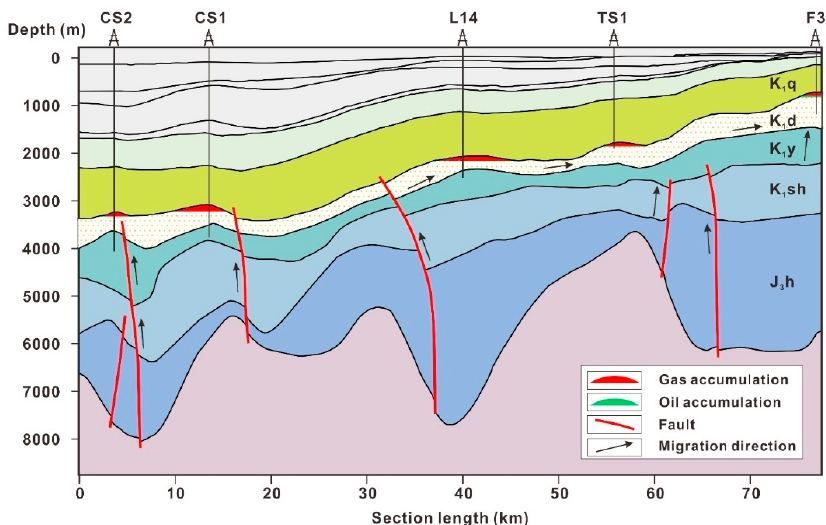
Figure 19. The cross section through wells, which shows the generalized hydrocarbon migration and accumulation model in K 1 d in the Changling Depression (section location shown in Figure 17).